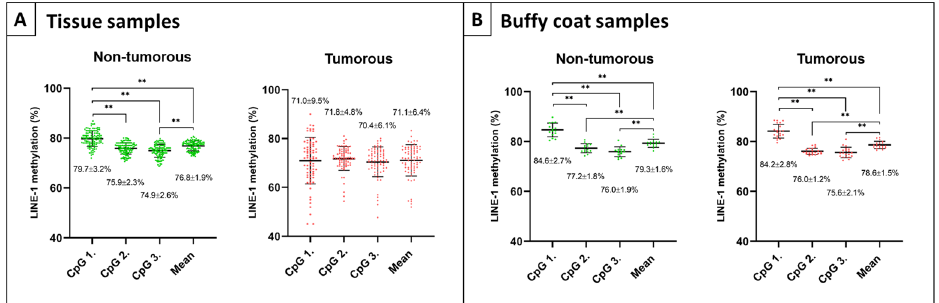
Figure 1. The methylation level of CpG sites of LINE-1 retrotransposon measured by the Pyromark Q24 CpG LINE-1 assay (Qiagen). ( A ) Significantly higher methylation level was observed in the case of the first CpG site compared to the second, third positions, and the mean methylation value in non-tumorous (N, AD-NAT, CRC-NAT, and IBD) tissue biopsies (** p ≤ 0.01) (left). Similar methylation levels of CpG positions were detected in AD and CRC tissue samples (right). ( B ) In buffy coat fractions of normal controls (left), along with patients with colorectal tumors (right), significantly elevated methylation value was detected in CpG 1 compared to positions 2, 3, and mean methylation (** p ≤ 0.01). Non-tumorous samples are represented in green, while tumorous specimens are marked in red.